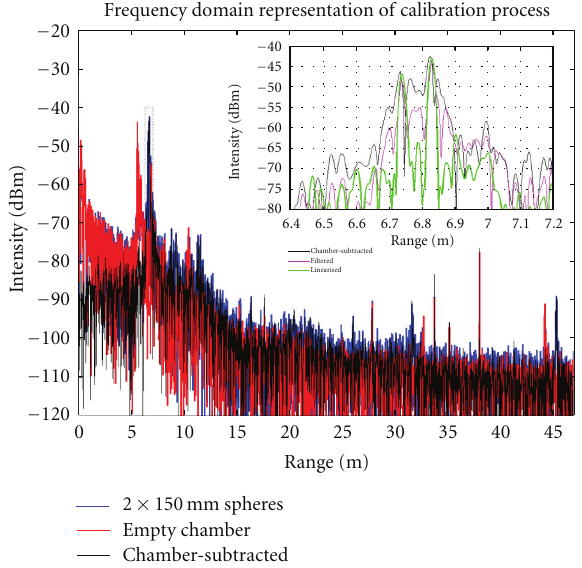
Figure 8: Signal linearisation of two targets closely separated in range.